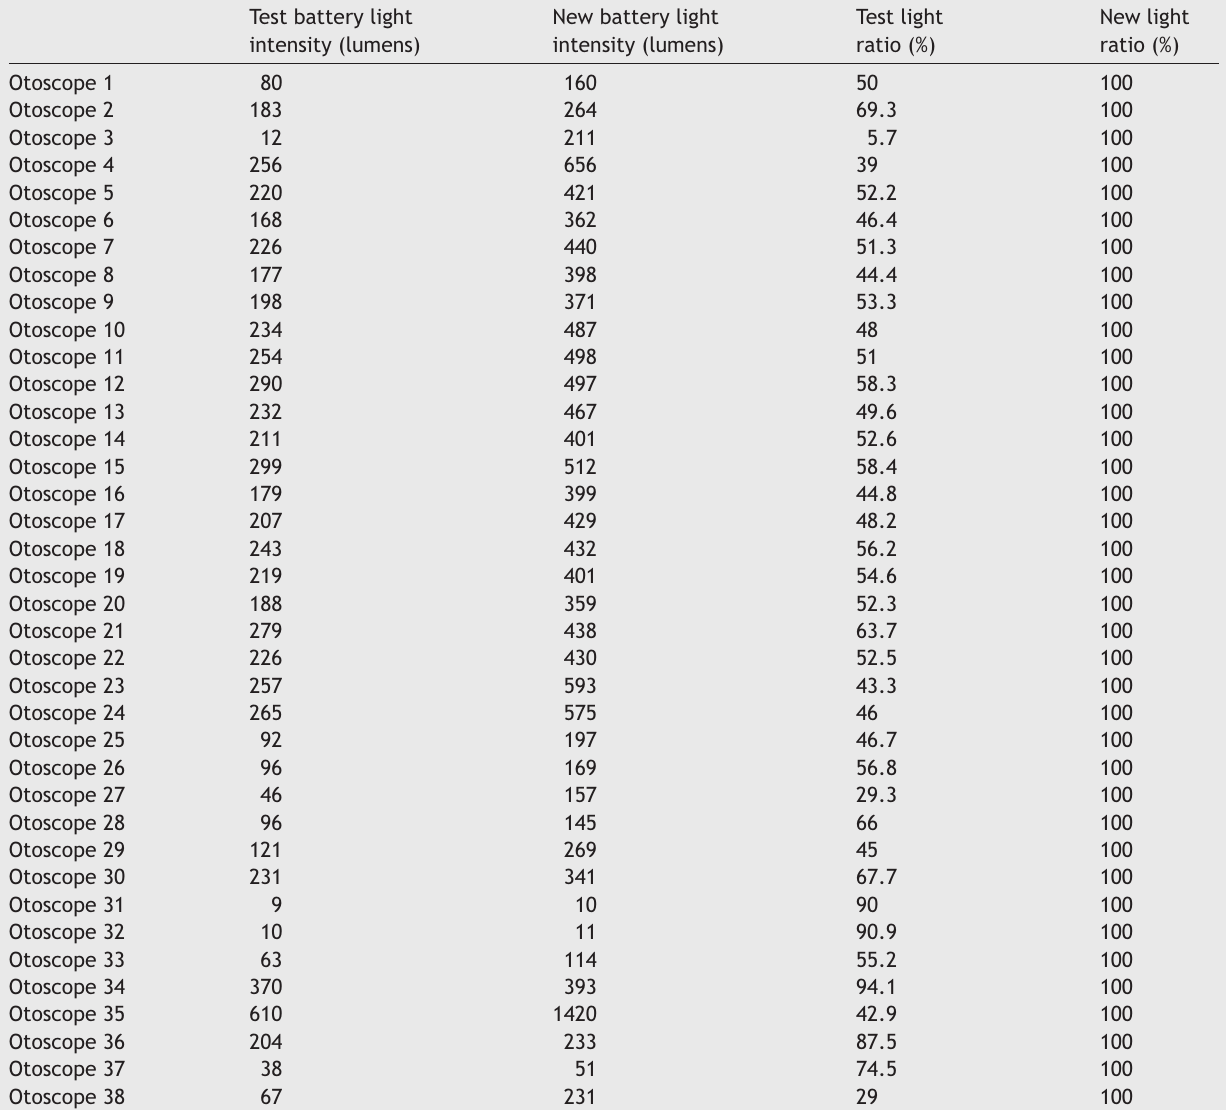
Light intensity and test battery light ratio in relation to the new batteries in each otoscope. Test battery